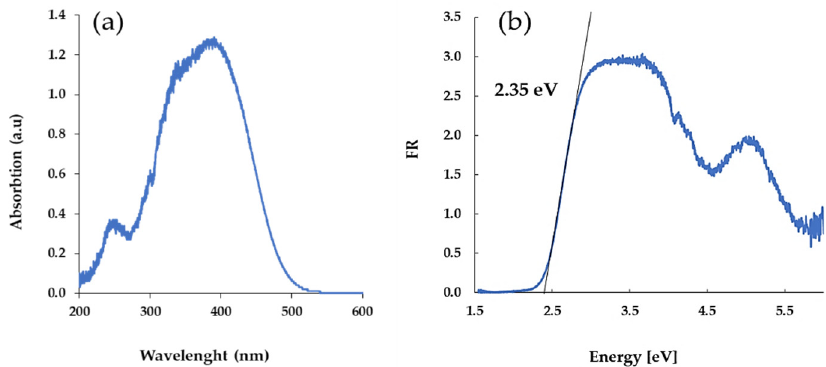
Figure 3. The solid-state UV–Vis diffuse reflectance spectra (DRS) of the micrograins ( a ), and light energy plot for the HOMO–LUMO gap determination ( b ).